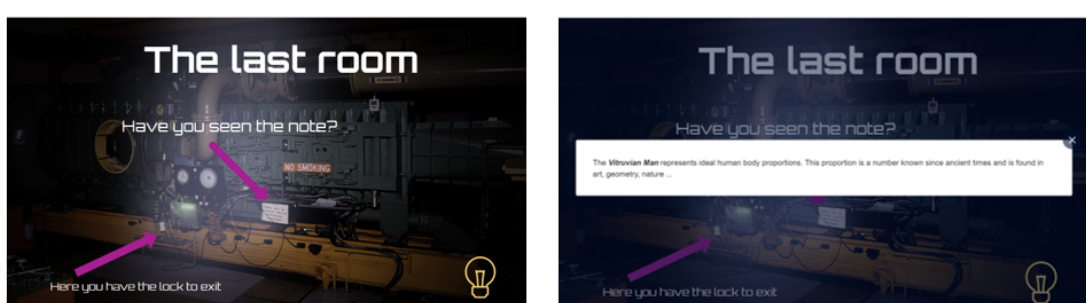
Figure A2. Initial screens.